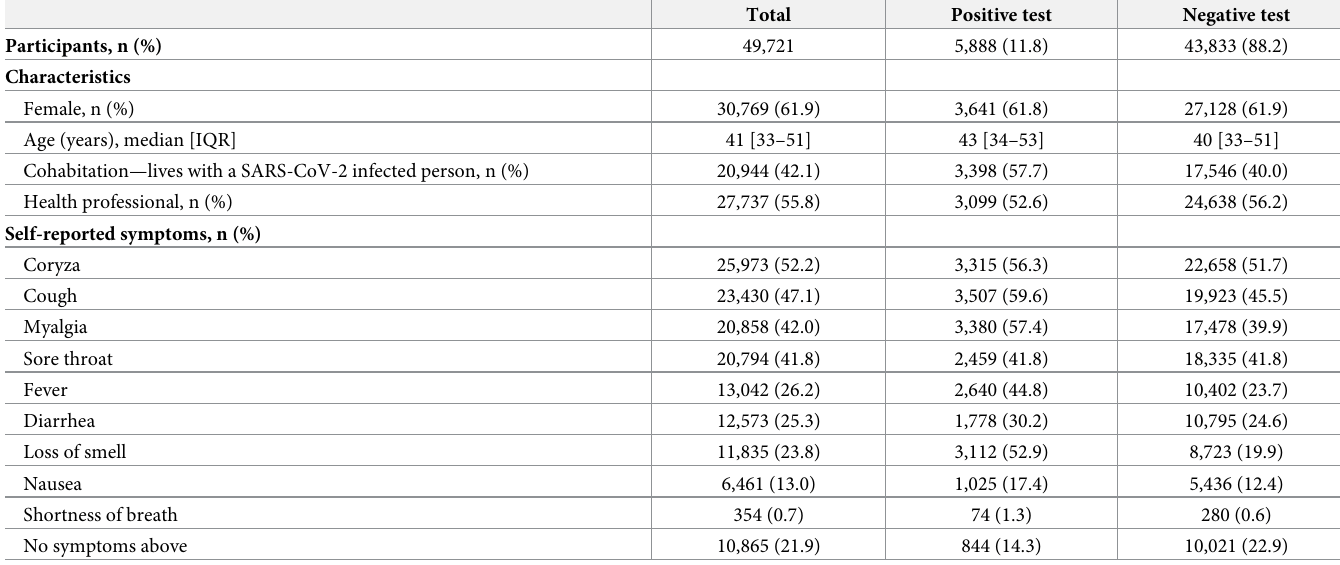
Table 1. Characteristics and symptoms of the study population tested for SARS-CoV-2 infection.